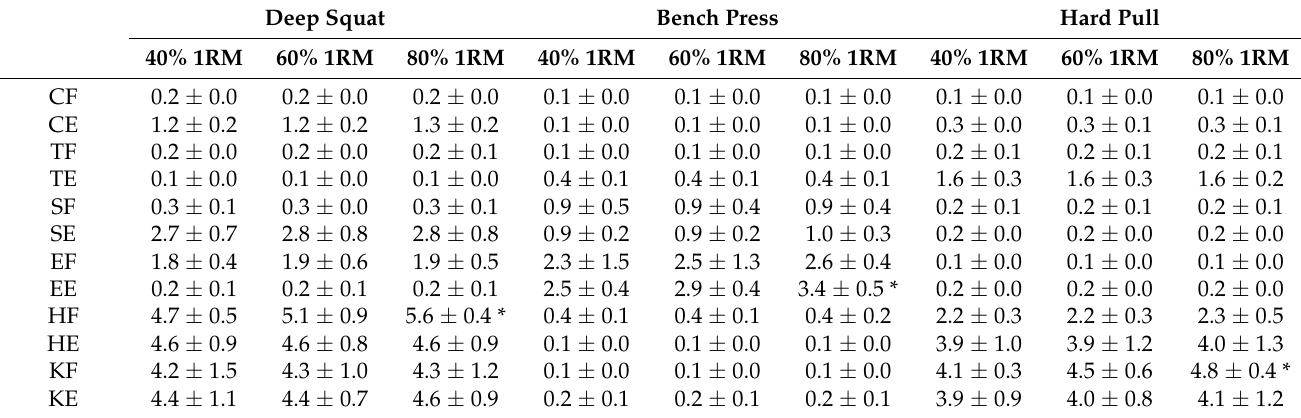
Table 3. Comparisons of the peak values of different load intensity test angular accelerations ( ◦ /s 2 ). Deep Squat Bench Press Hard Pull